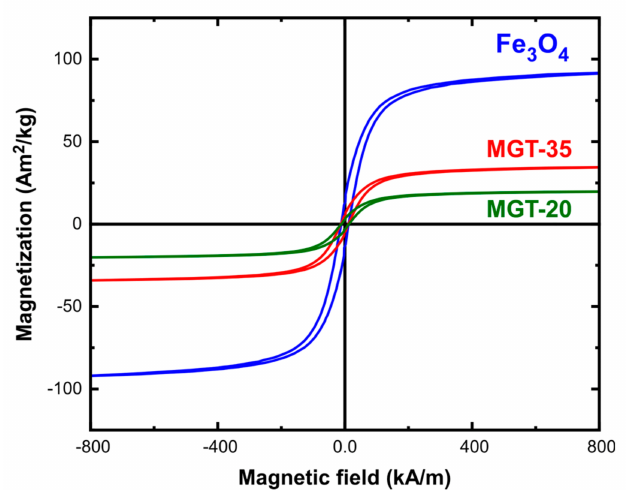
Figure 4. TEM images of the pure hydrotalcite phase ( a ) and the IONPs ( b ). Corresponding images showing the nanostructure of MGT-20 ( c ) and MGT-35 ( d ).